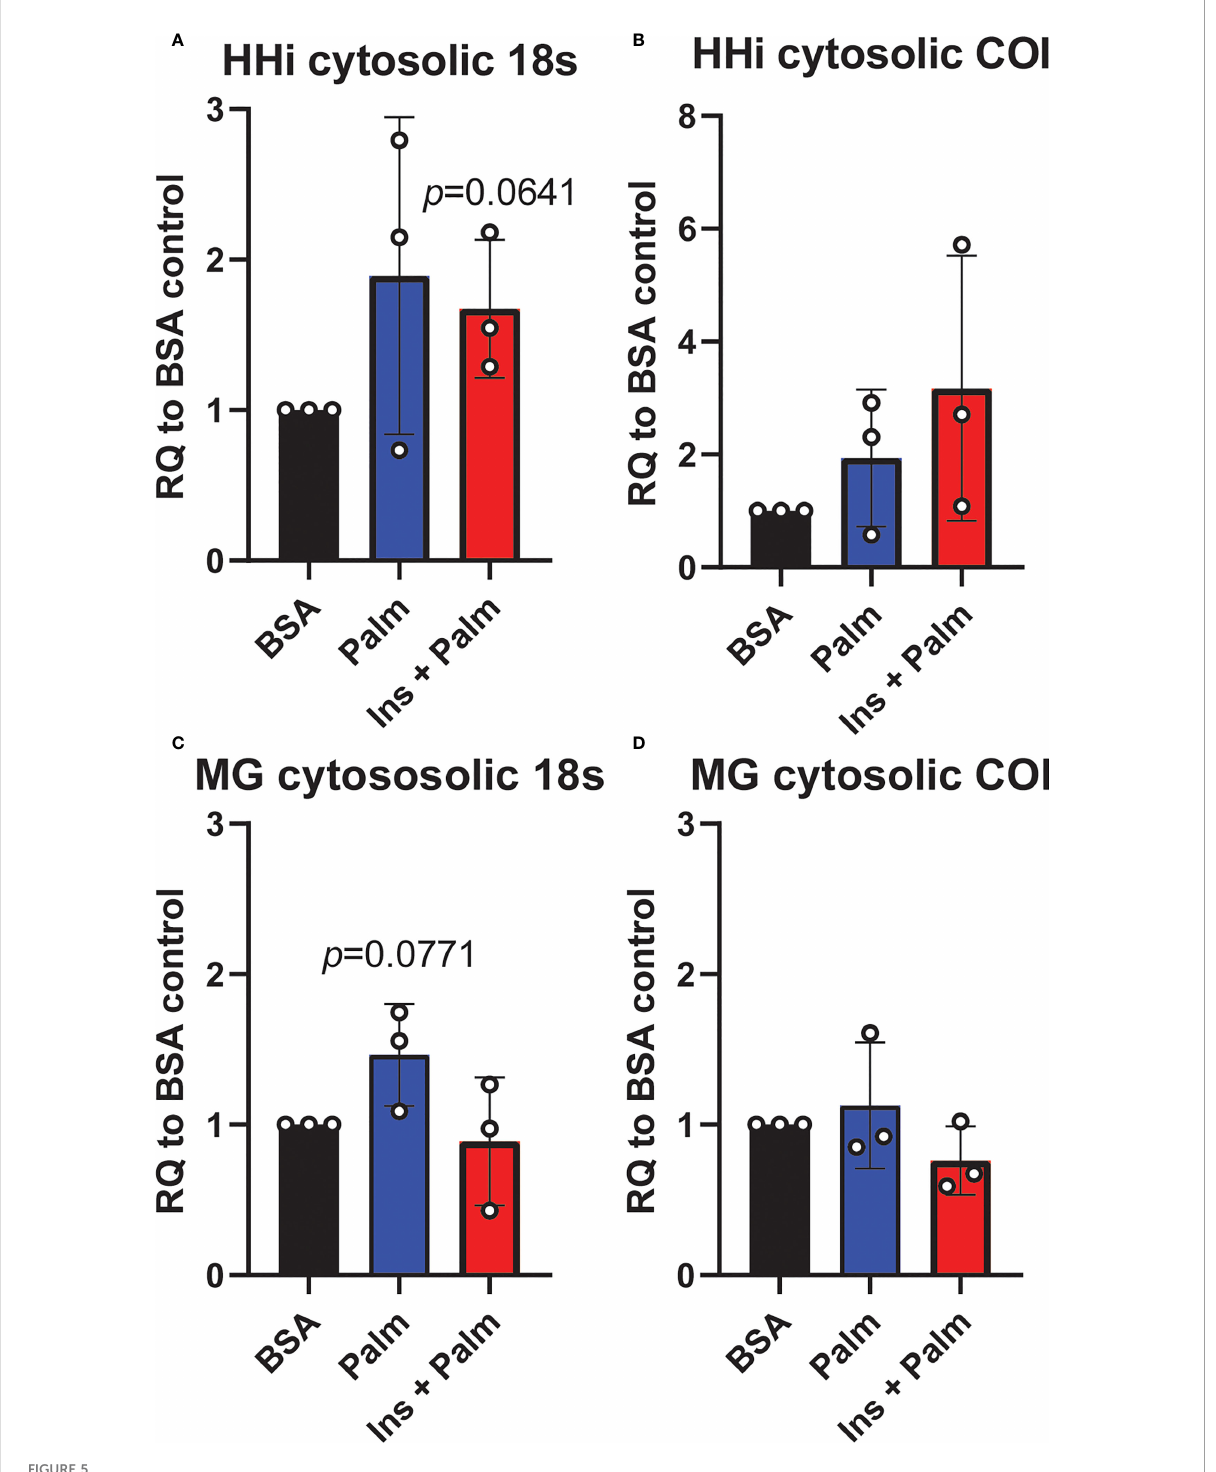
FIGURE 5 Cytosolic DNA concentrations. Relative quantity (RQ) of cytosolic DNA (nuclear and mitochondrial) in partially immortalized human hippocampal neurons (HHi; n=3, A, B ) and in a human microglial cell line (MG; n=3, C, D ). Cells treated with palmitate (Palm; HHi=250 m M, microglia=62.5 m M, 24h) or a combination of insulin and palmitate (Ins + Palm; above palmitate concentrations + 50 nM insulin, 24h). Values relative to BSA